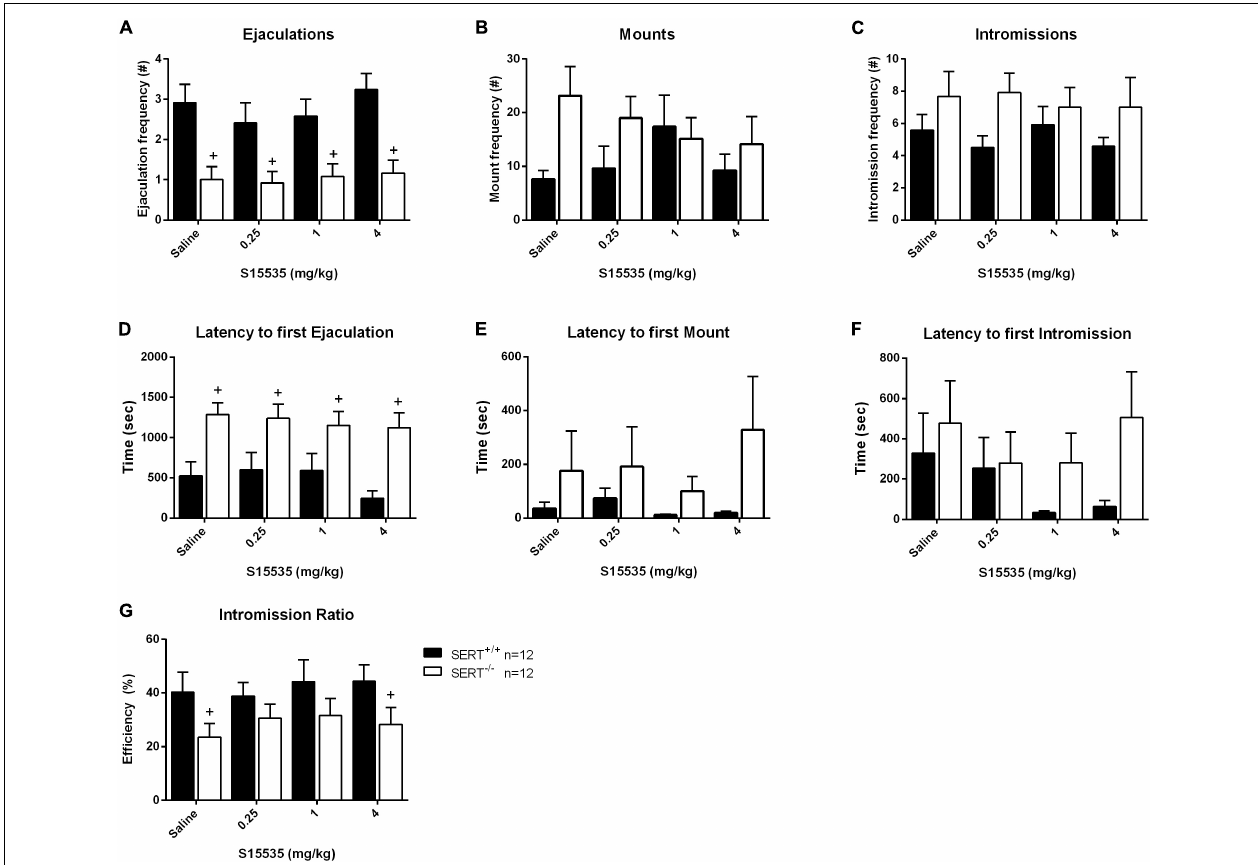
FIGURE 5 | Sexual behavior of male rats from normal ejaculating rats treated with 0, 0.25, 1, or 4 mg/kg S15535. The number and latency of ejaculations per 30 min (A,D) , number and latency of Mounts (B,E) , number and latency of Intromissions (C,F) , post-ejaculatory interval (G) , and Intromission Ratio (H) of the first Ejaculation Series are provided. Detailed statistical analyses are displayed in Supplementary Table 3 . +Significant difference between SERT + / + and SERT − / −